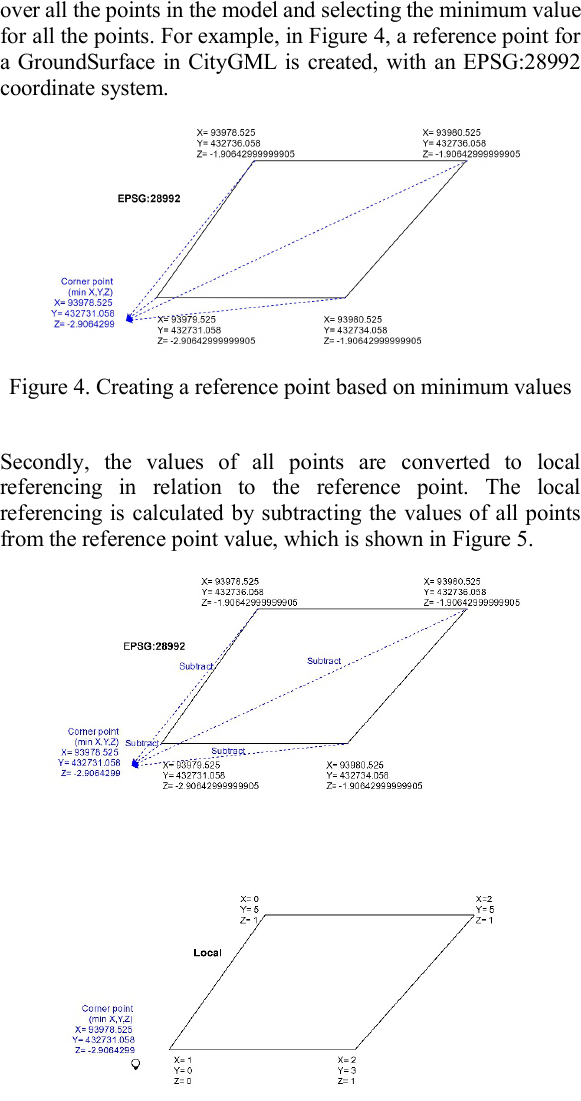
Figure 5. Converting calculating local referencing to all points Lastly, latitude, longitude in WGS 84, and elevation of a project are dedicated to the IFCSite class (Diakité, 2018). BIM model coordinates are usually stored in an IFC transformation